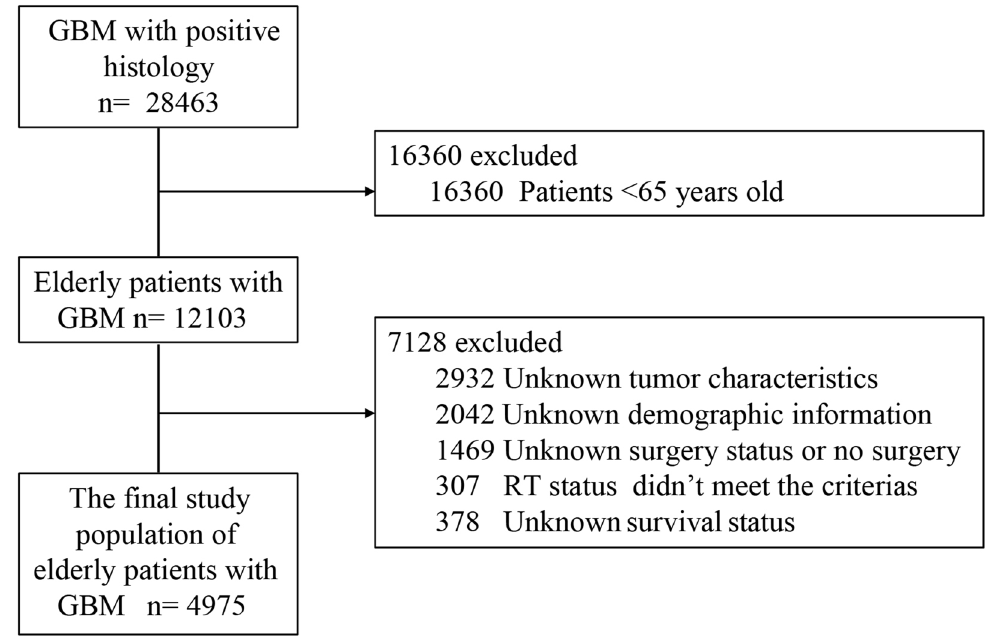
Figure 1. Flowchart of elderly with glioblastoma